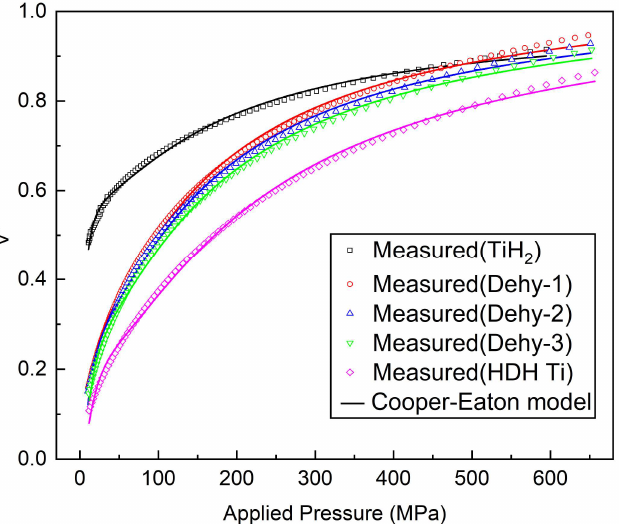
Figure 7. TiH 2 , Dehy-1, Dehy-2, Dehy-3 and HDH Ti powders compaction data fitted according to Equation (2). Table 4. Fit Parameters to Equation (2) for the Powder Materials Under Investigation.